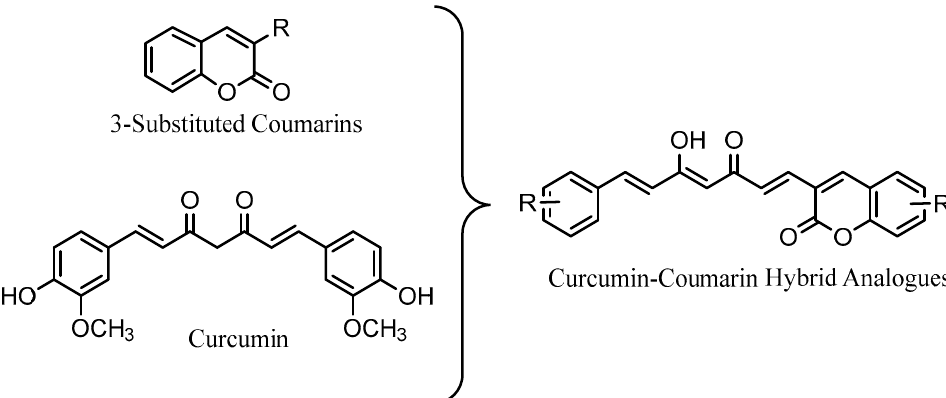
Figure 1. Overview of design of new curcumin–coumarin hybrid